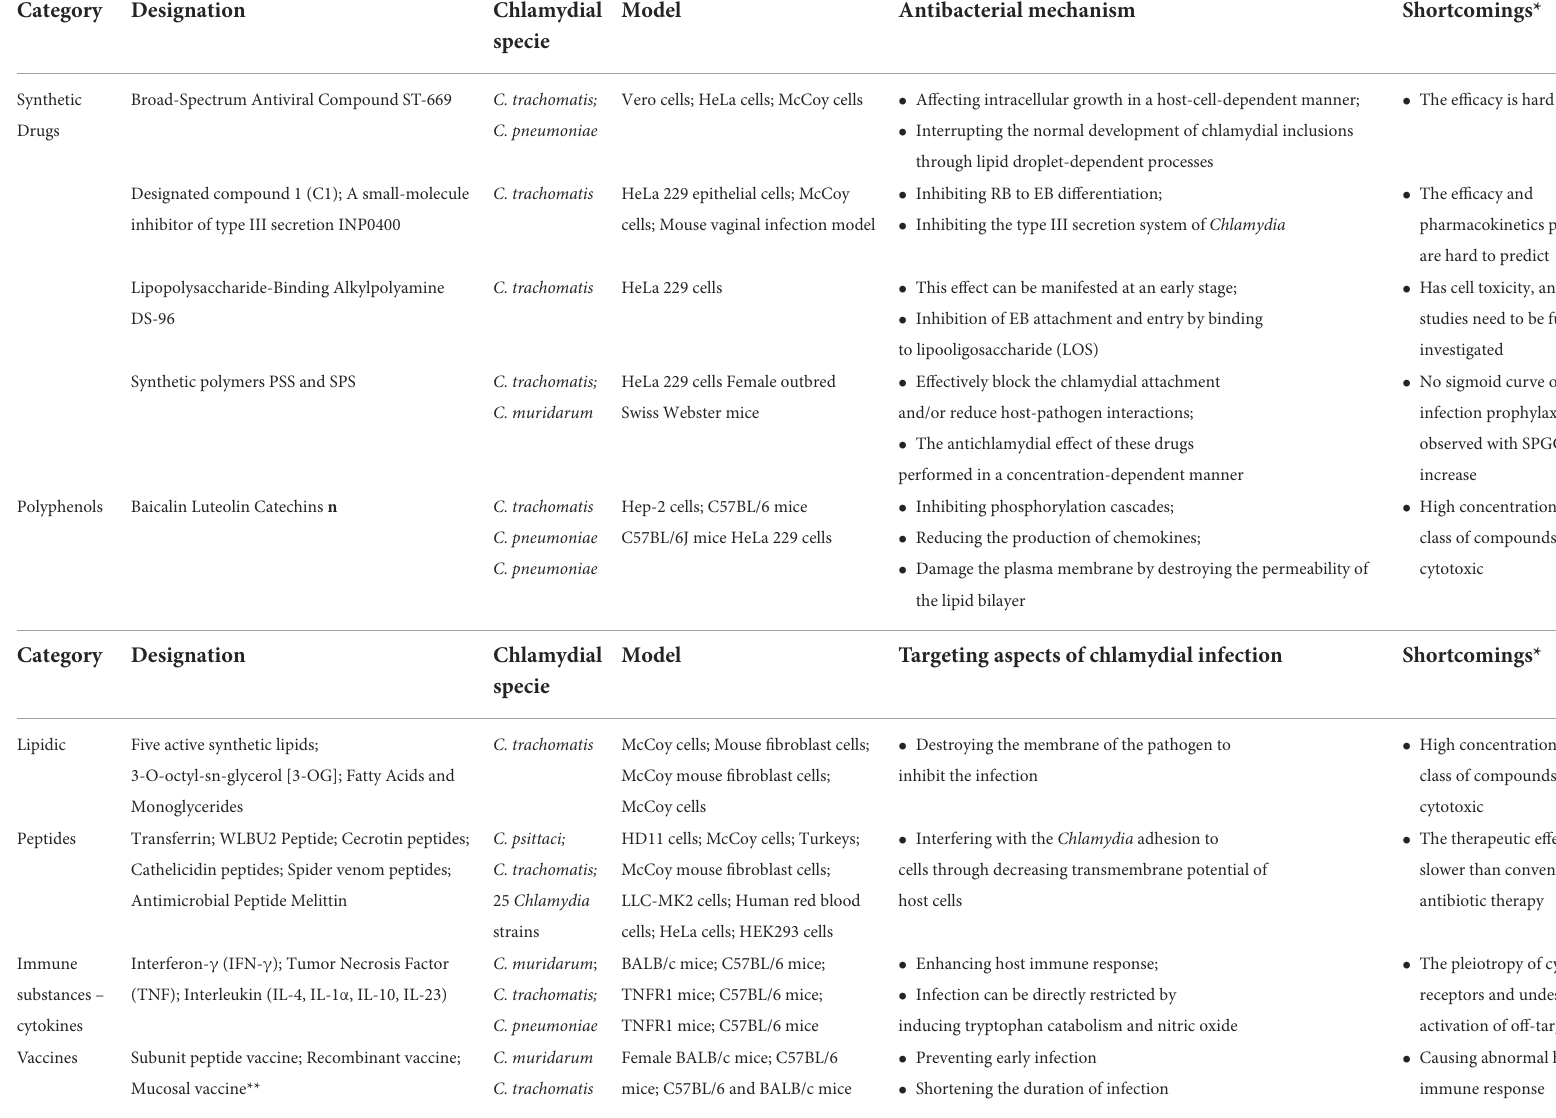
TABLE 1 Past studies exploring the anti-chlamydial properties of non-antibiotic